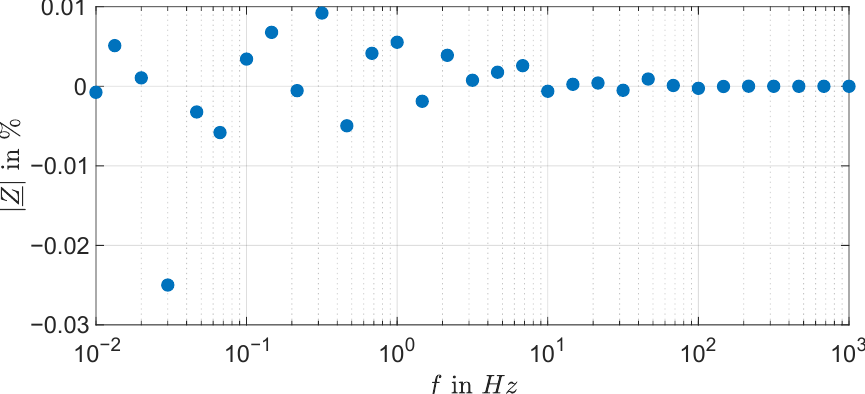
Figure 14. Regularized Linear Kramers-Kronig residual analysis of the measured lithium-ion impedance